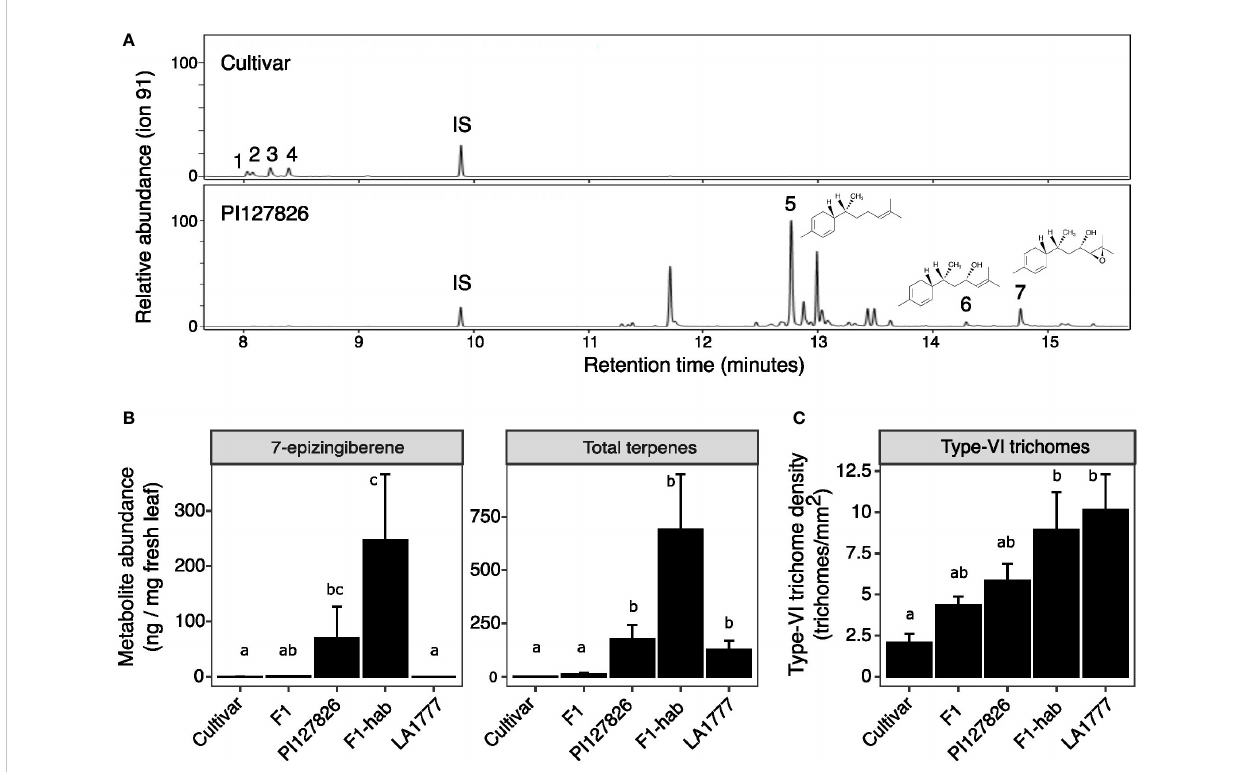
FIGURE 1 Metabolite levels and trichome density on leaves of tomato hybrids and their parents. (A) GC-MS chromatograms of the S. lycopersicum cultivar and S. habrochaites PI127826. Peaks: (1) 2-carene; (2) a -phellandrene; (3) terpinolene; (4) b -phellandrene/D-limonene; (5) 7-epizingiberene; (6) 9- hydroxy-zingiberene; (7) 9-hydroxy-10,11-epoxyzingiberene; (IS) internal standard. Molecular structures are given for 5, 6 and 7. (B) 7-epizingiberene and total mono-and sesquiterpene abundance on the leaves of the cultivar x PI127826 F1 hybrid (F1), the S. habrochaites hybrid PI127826 x LA1777 (F1-hab) and their parents. Bars represent mean level of metabolites per mg fresh leaf ± SE (n = 3). (C) Type-VI trichomes density on the leaf. Bars represent mean ± SE (n = 3) summed densities over the abaxial and adaxial surface. Statistics were performed after log transformation; letters indicate signi fi cant groups (p < 0.05) according to a Tukey HSD post-hoc test after